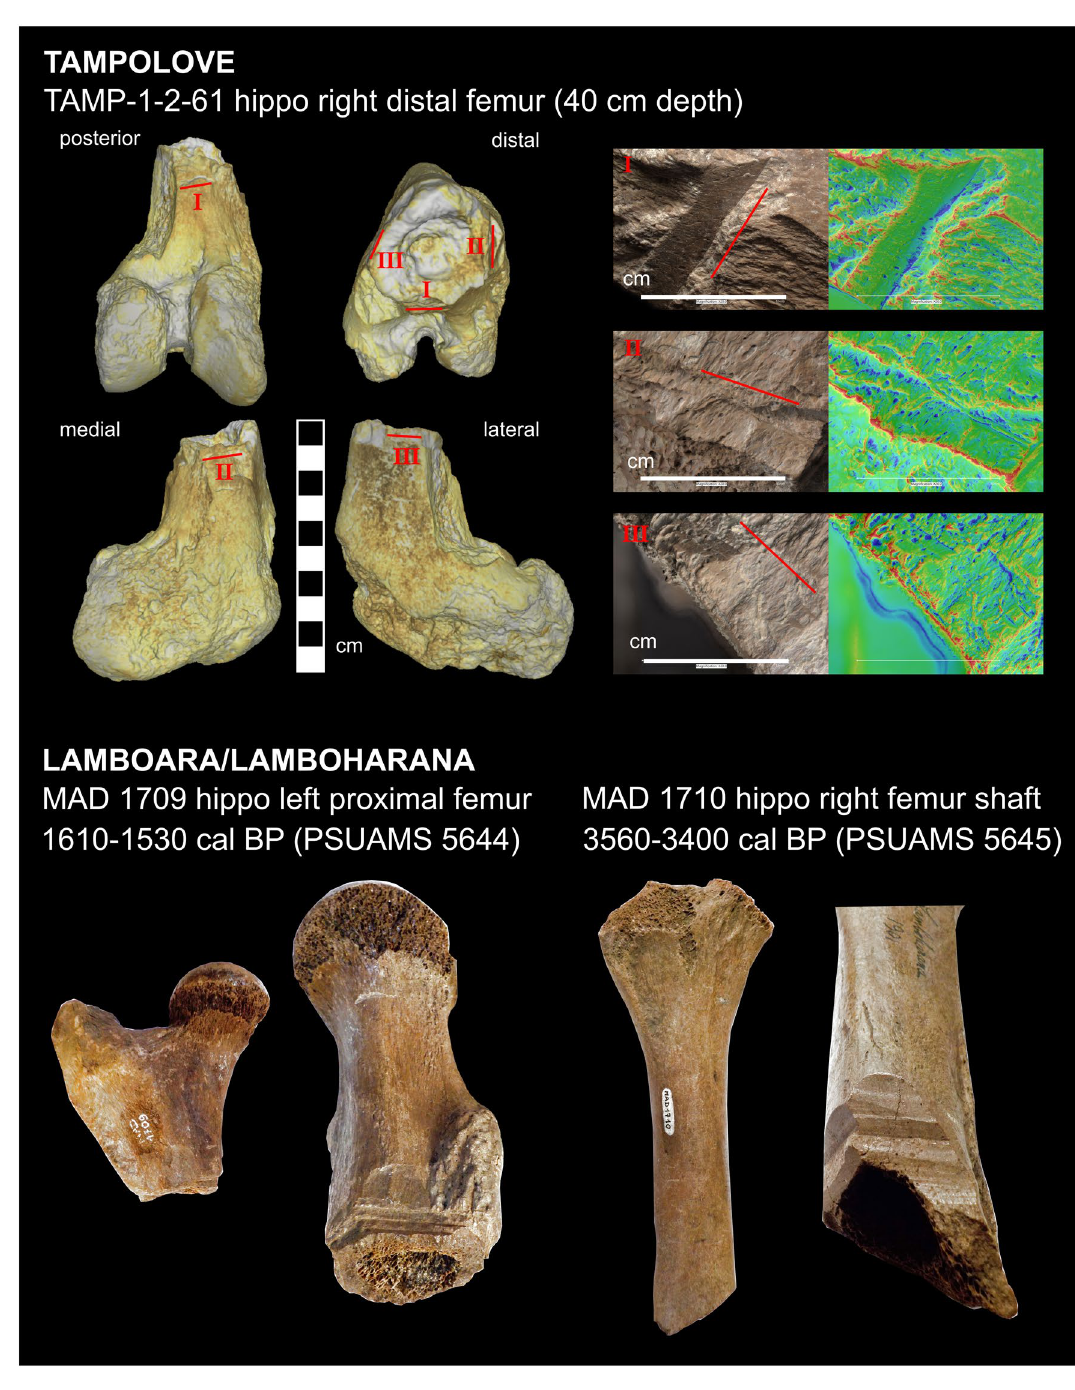
Figure 4. Cutmarked pygmy hippo femur recovered from Tampolove during recent excavation at ~ 40 cm depth (TAMP-1-2-61, above), and previously-recovered and directly 14 C-dated (~ 3500 and 1600 cal BP 37 ) cutmarked pygmy hippo femora from the nearby site of Lamboara/Lamboharana that are currently housed in the National Museum of Natural History in Paris (MAD 1709 & MAD 1710, below). Four views highlight three locations of cutmarks on the broken shaft of TAMP-1-2-61, and the inset frames show 20 × magnification of these areas, with corresponding orientations given by red lines. Note that the false color insets of TAMP-1-2-61 are meant to highlight linear edges and crevices, and the overview photos of all three femur fragments are on the same